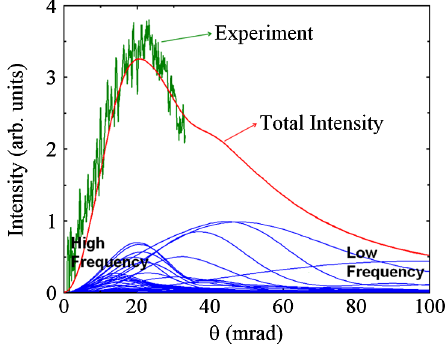
FIG. 7. Spatial intensity distributions for different frequencies, total spatial intensity, and experimental result at R ¼ 25 cm .